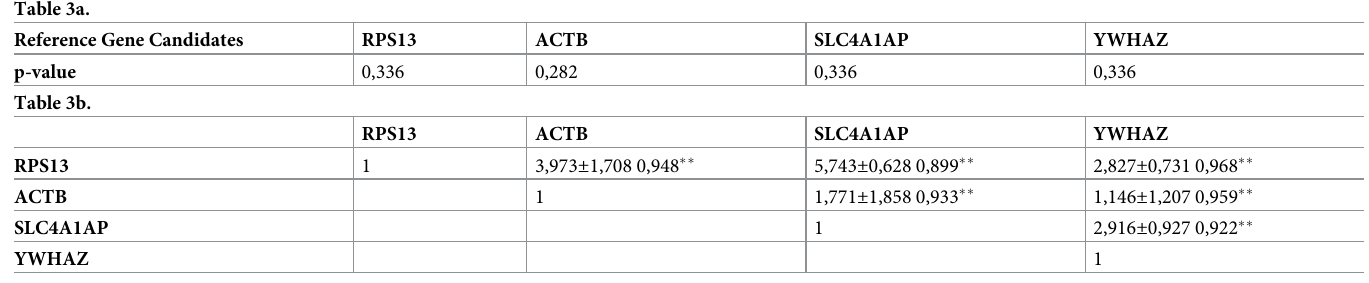
Table 3. Comparison of the expression of each reference gene in HT and non-diseased control biopsies. 3a displays the pvalues from the qPCR experiments. Data were analyzed by Mann-Whitney Asymp. Sig. (2-tailed). None of the comparisons yielded statistically significant results. 3b shows the fold change (FC) differences and Table 3a.